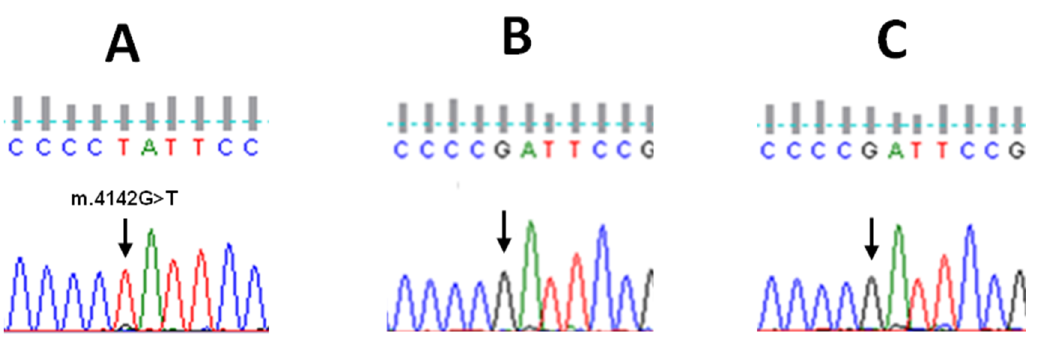
Figure 3. (A) Electropherogram showing the m.4142G>T in patient 1; (B) Electropherogram of his mother; (C) Electropherogram of his sibling.